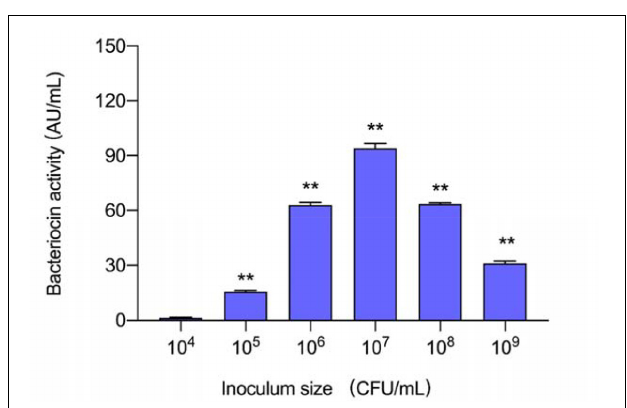
FIGURE 1 | Effect of different inoculum sizes of L. plantarum RX-8 on the production of plantaricin. ** p < 0.01.